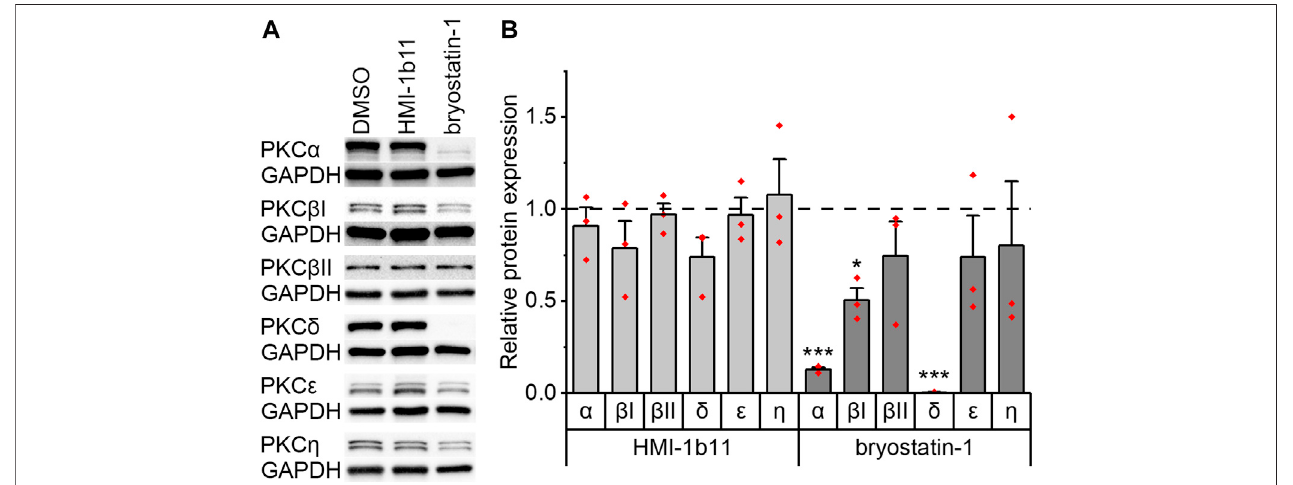
FIGURE 2 | Effects of PKC agonists on the expression of PKC isoforms α , β I, β II, δ , ε and η in hiPSC-CMs. The cells were exposed to HMI-1b11 at 10 µM or bryostatin-1 at 10 nM for 48 h and proteins were detected by Western blotting. (A) Representativeblots; (B) quanti fi cation ofWestern blots expressed as mean + SDof three independent experiments of cardiomyocytes from individual differentiations (day 57 – 182). Results are normalized to GAPDH and to DMSO control. *** p < 0.001, * p < 0.05 vs. DMSO control (Welch ANOVA followed by Games-Howell). The original full images of immunoblots are shown in Supplementary Figure S4